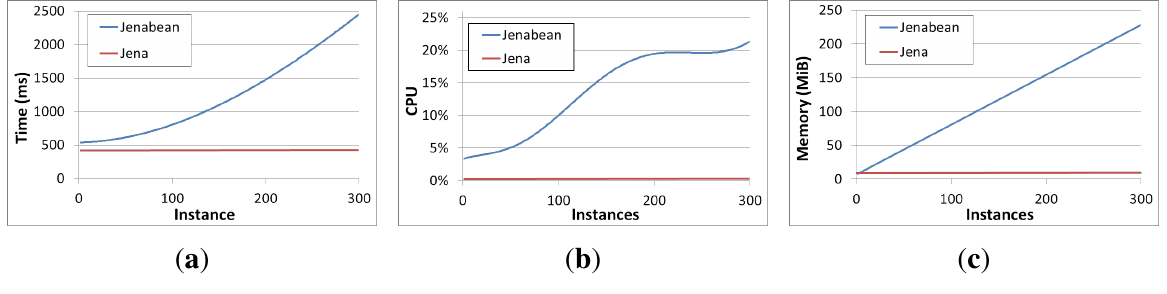
Figure 6. System performance in reasoning—Jena and Jenabean comparison. ( a ) Adding